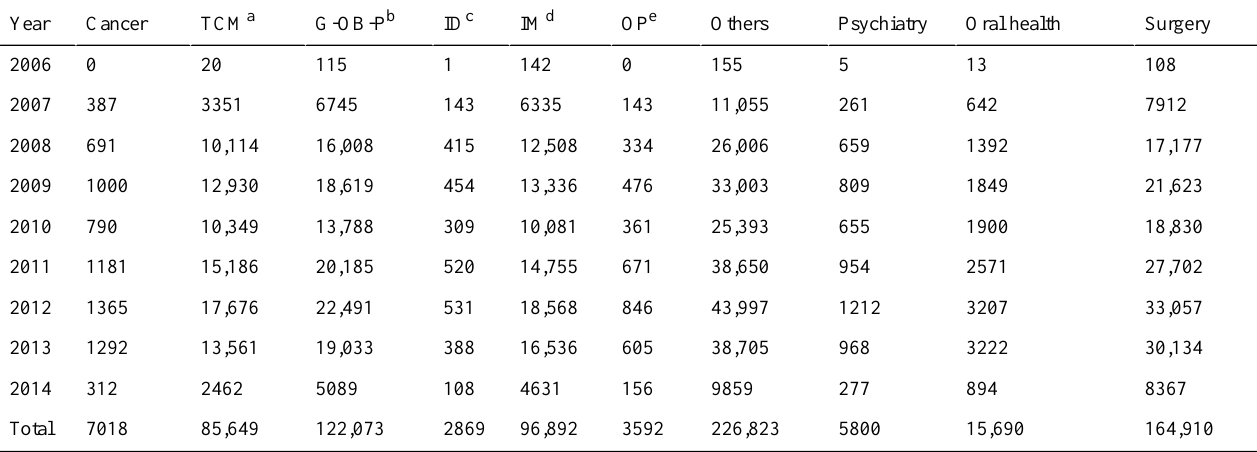
Table 2. Number of reviews for each specialty per